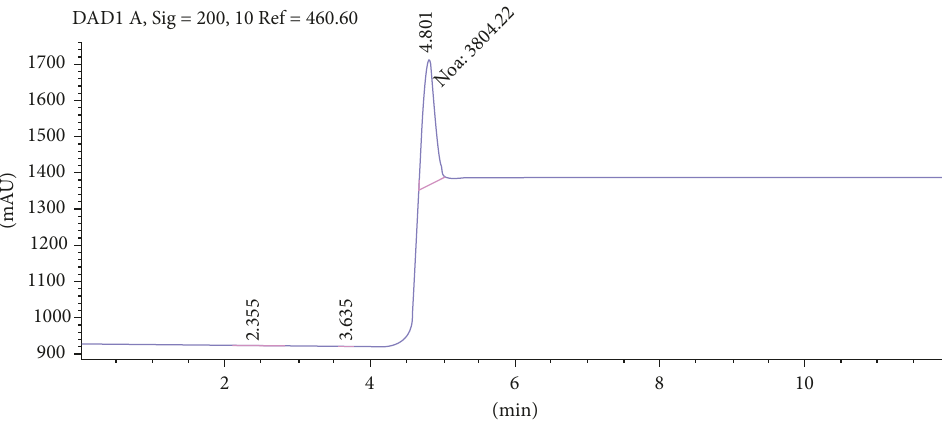
Figure 4: Glucose peak of the P2 sample and relative retention time ( T